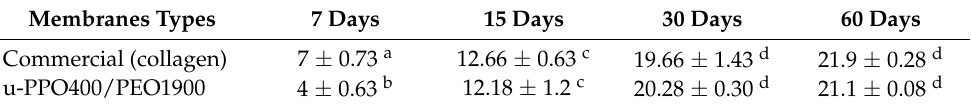
Table 2. Percentage of bone tissue volume in the critical-sized bone defect at 7, 15, 30, and 60 days after the surgical procedure. Values expressed in percentage of volume and mean ± SD.